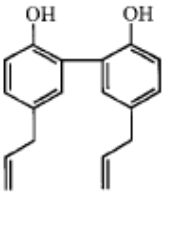
Figure 1. Structure of